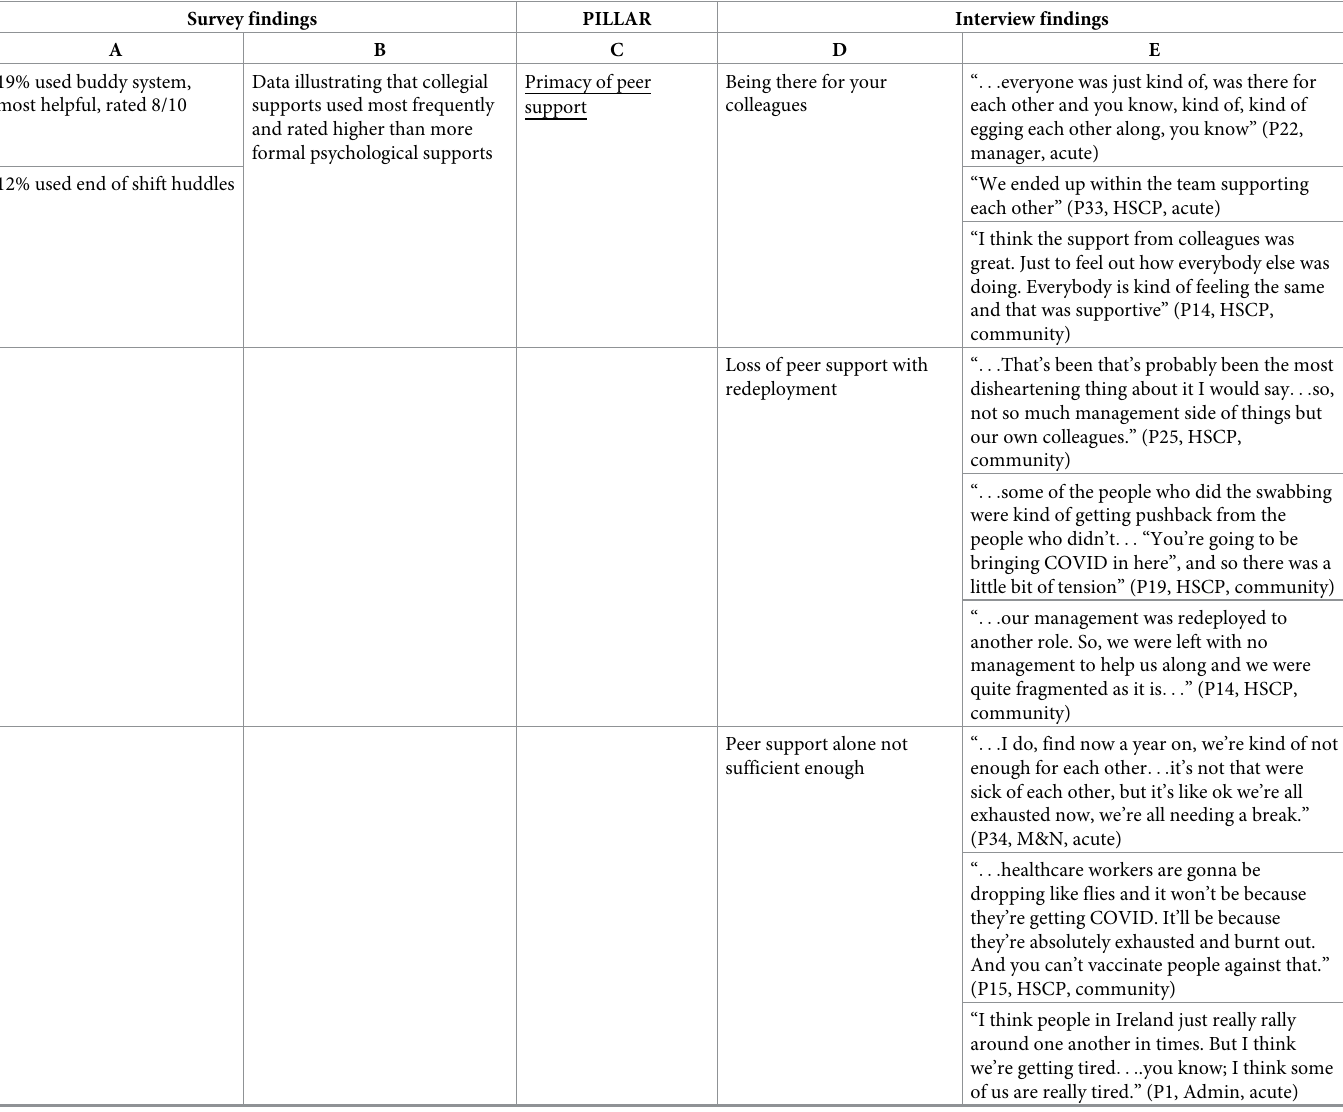
Table 4. A joint display of the connections between the quantitative and qualitative data arising from the study. Survey findings